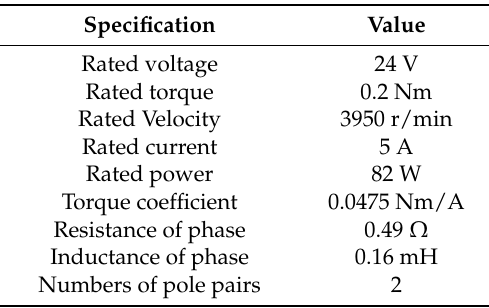
Figure 5. The experiment platform. Table 2. Specifications of the brushless DC motor (BLDCM).